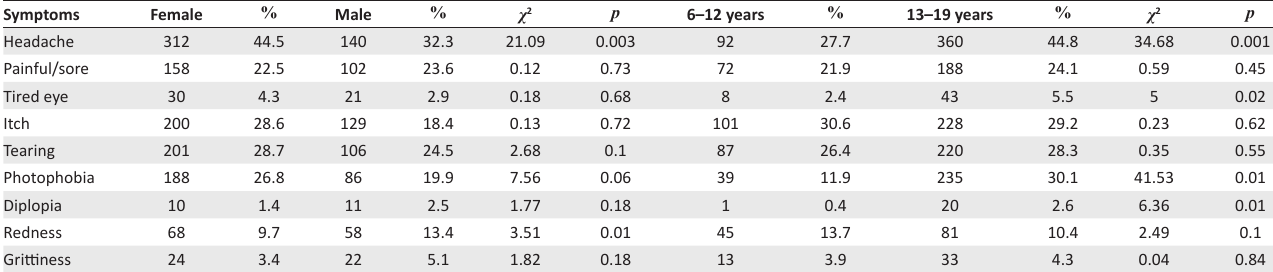
TABLE 3: Frequency ( n and percentage) of symptoms according to gender and age groups. Symptoms